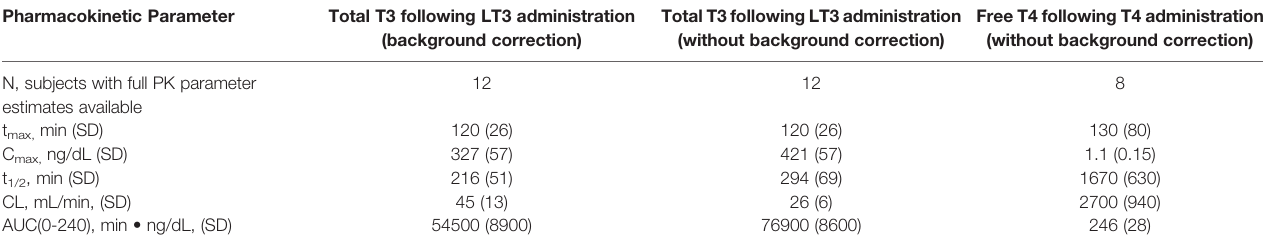
TABLE 2 | Non-compartmental analysis pharmacokinetic parameter estimates. Pharmacokinetic